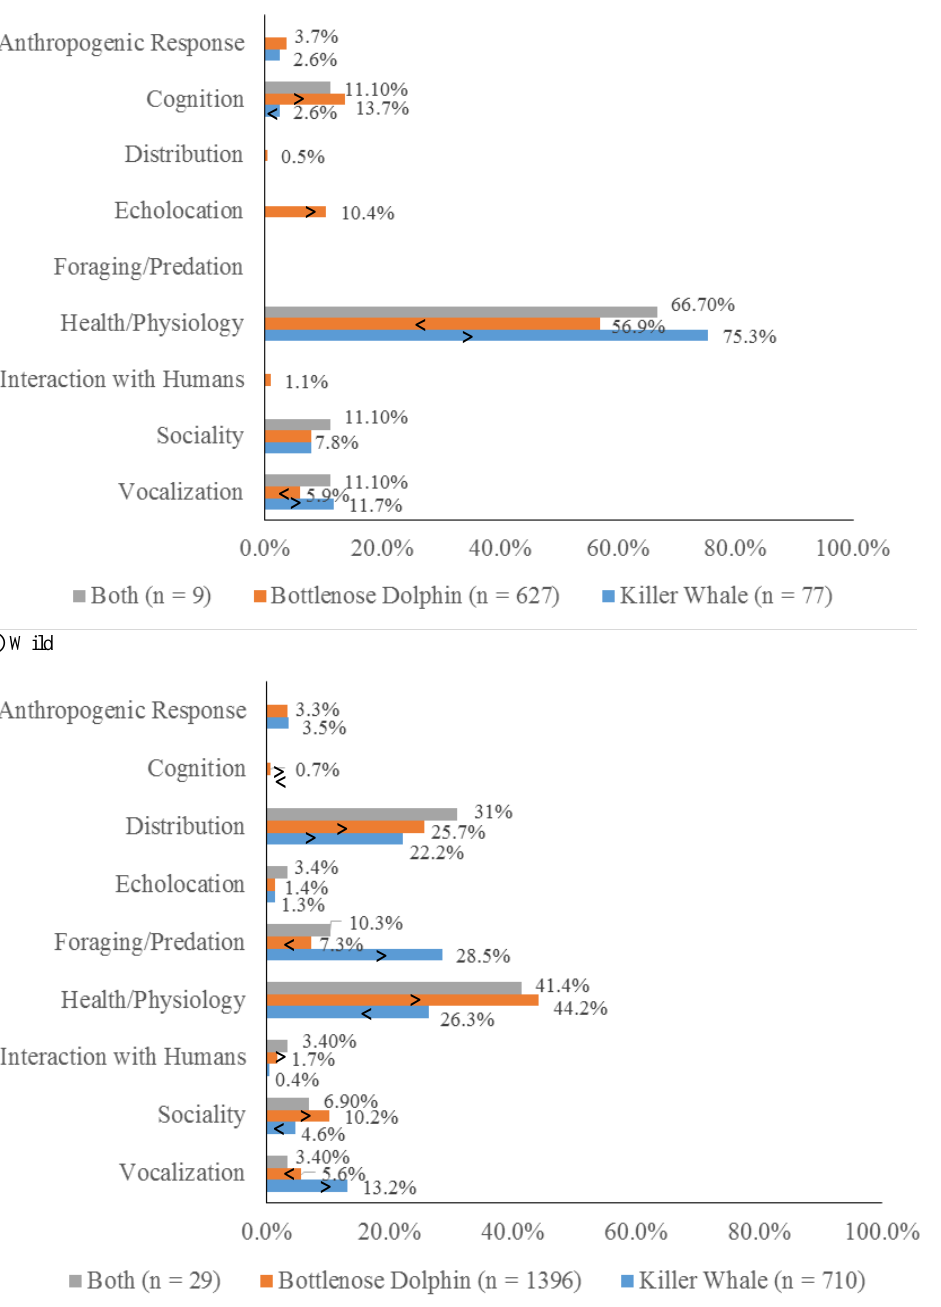
Figure 2. Distribution of articles for topic per species based on captivity (A) and wild (B) settings. A > sign indicates that a topic was represented significantly more often in the species comparison. A < sign indicates that a topic was represented significantly less often in the species